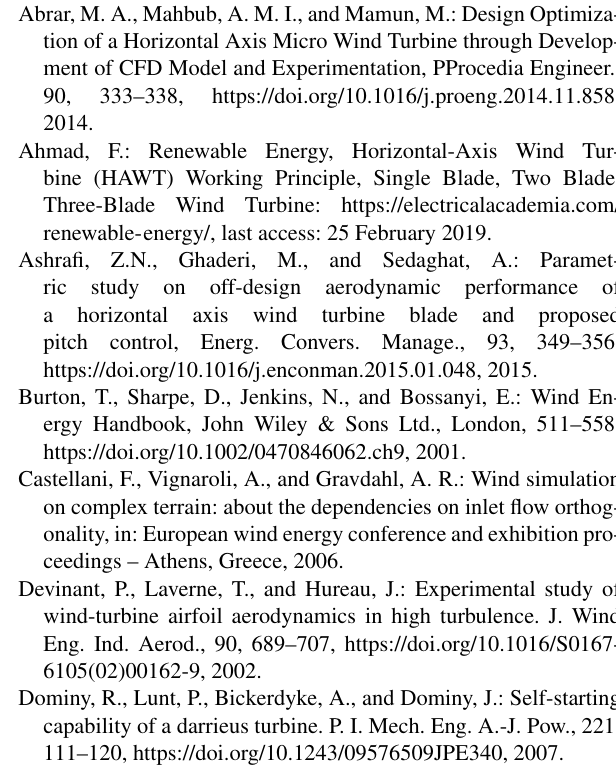
eration from horizontal axis wind turbines based on ro- tor blade and hub